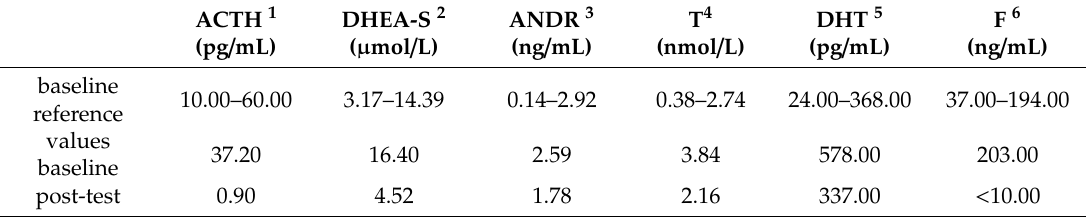
Table 5. Results of the three-day dexamethasone suppression